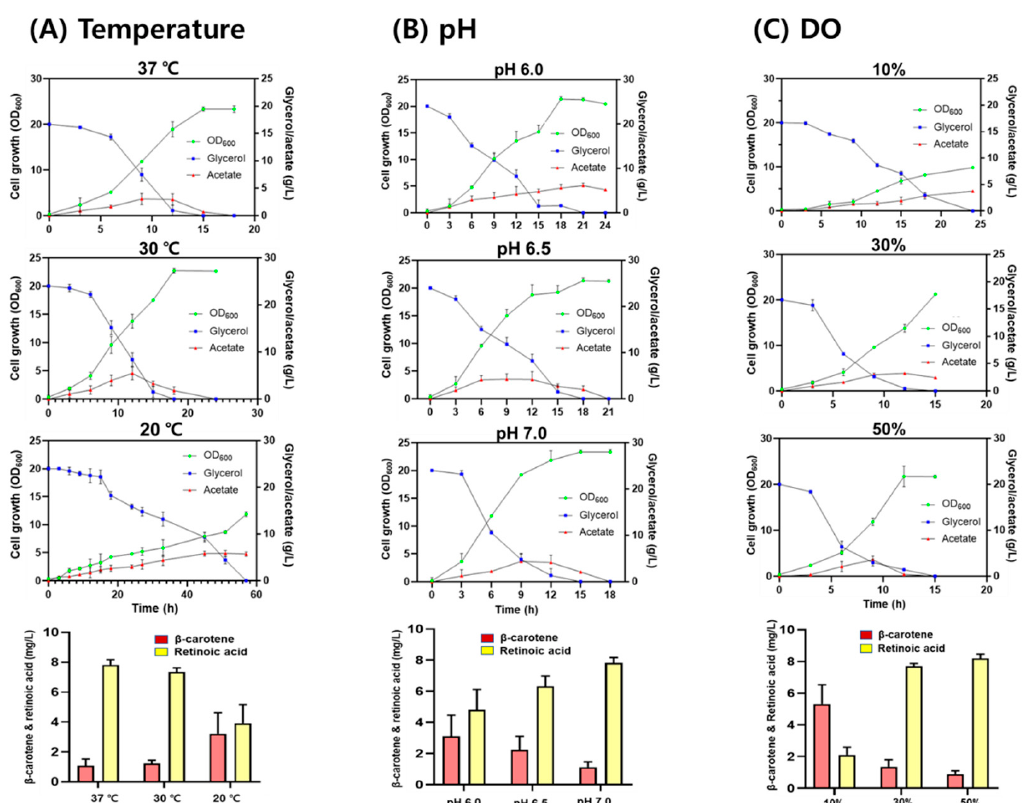
Figure 5. Batch fermentation of the RA10 strain under different culture conditions. ( A ) Effect of temperature (20, 30, and 37 °C) on cell growth at pH 7.0 and a DO of 30%. ( B ) Effect of pH (6.0, 6.5, and 7.0) on cell growth at 37 °C and a DO of 30%, ( C ) Effect of DO (10%, 30%, and 50%) on cell growth at pH 7.0 and 37 °C. Cell growth (OD 600 ) is represented as a green circle; glycerol concentration, a blue square; acetate concentration, a red triangle.